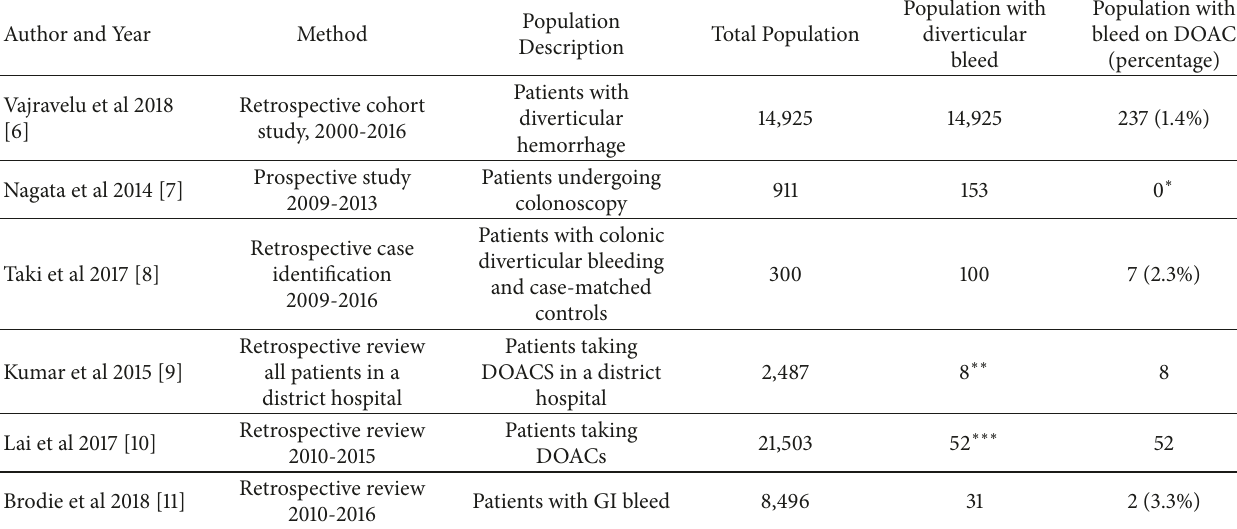
Table 1: Summary of reference articles regarding risk of diverticular bleed in DOAC